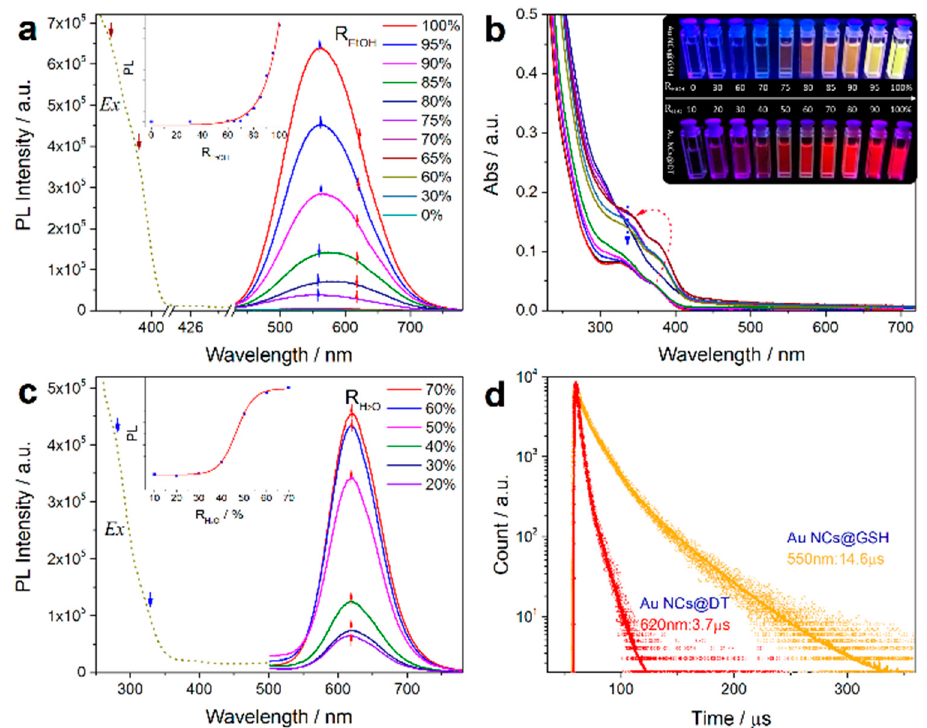
Figure 15. Solvent-induced ligand-dependent optical absorption and emissions. Photoemission and excitation spectra of water-soluble Au NCs@GSH ( a ) and oil-soluble Au NCs@DT ( c ) in mixed solvents with different volume fractions of R (Inset, relationship between the luminescence intensity and R (R EtOH = Vol EtOH /Vol EtOH + H2O , R H2O = Vol H2O /Vol EtOH + H2O ), the spectra were recorded at 0.5 h after the sample preparation). ( b ) Ultraviolet-visible (UV − vis) absorption spectra of Au NCs@GSH in mixed solvents with different R EtOH . Inset shows the digital photos of water-soluble Au NCs@GSH and oil-soluble Au NCs@DT in mixed solvents of ethanol and water with varied volume fractions of R EtOH and R H2O under UV light. ( d ) Time-resolved luminescence decay profiles of solvent-induced luminescent Au NCs@GSH and Au NCs@DT. Reprinted with permission from Ref. [43]. Copyright (2019) Springer Nature. GSH: glutathione.